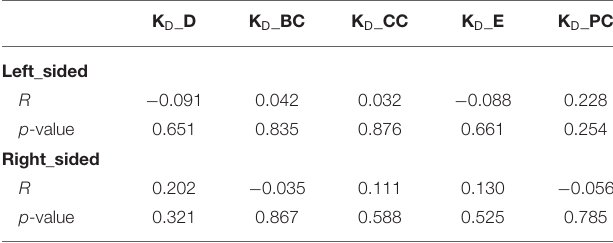
TABLE 2 | No significant correlations between the 5 disruption indexes in 2 subgroups and baseline FMA_UE at link density =